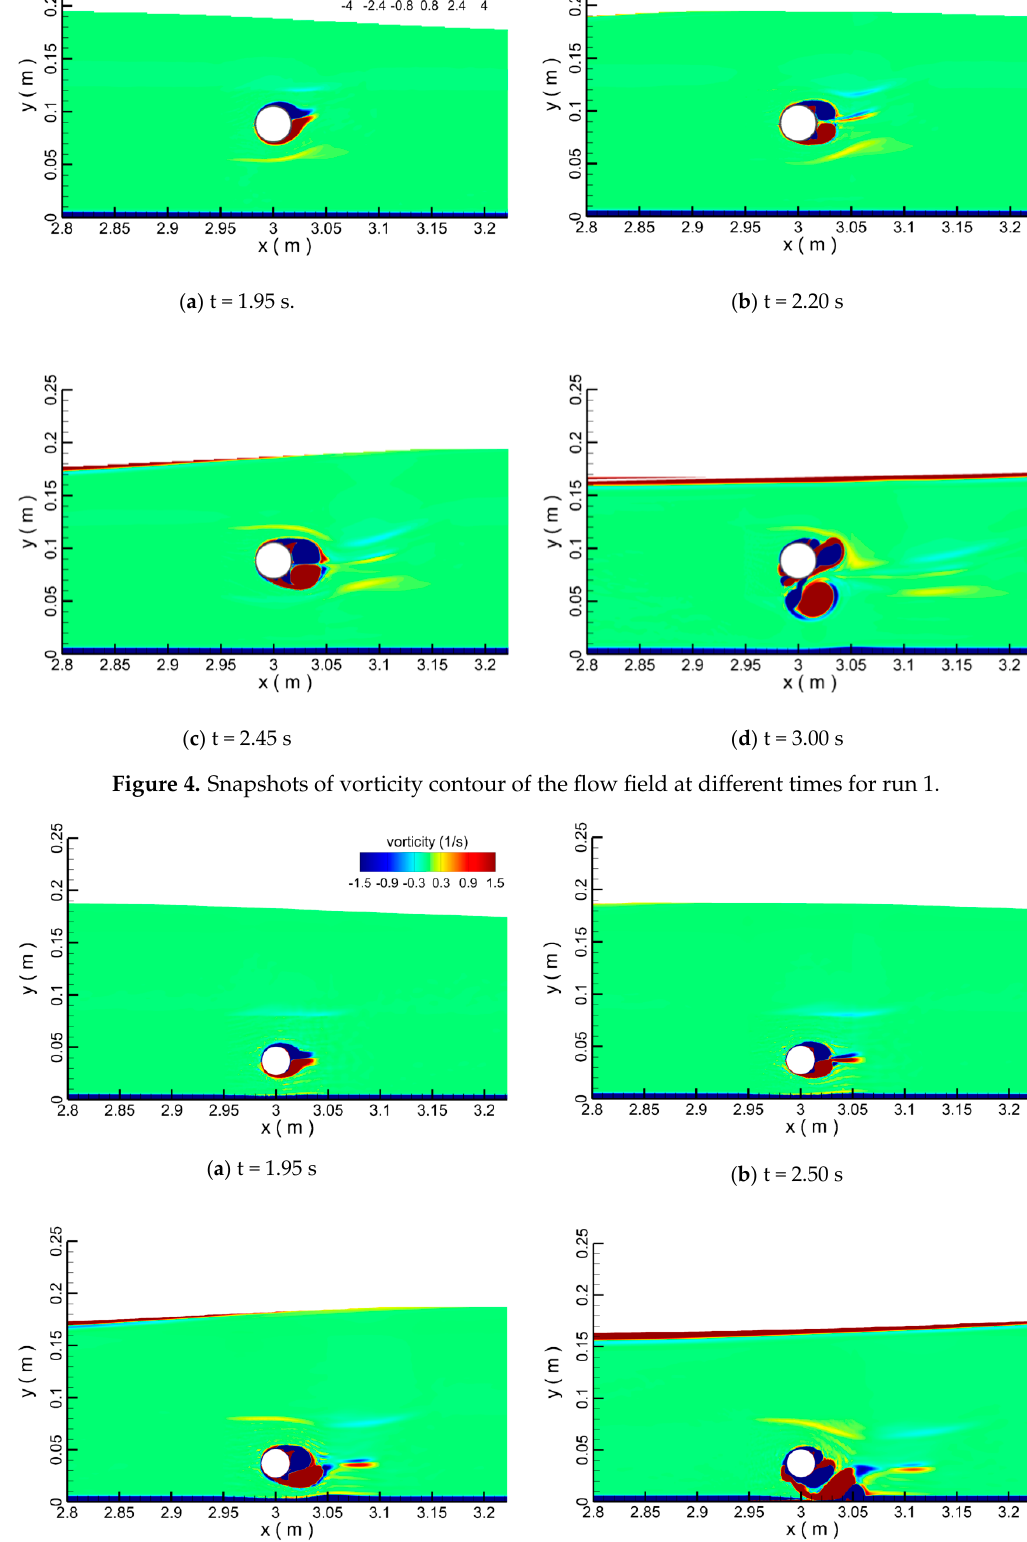
( b ) Figure 6. Force comparison between measurement and simulation in run1; ( a ) horizontal force F x *; ( b ) vertical force F z *.